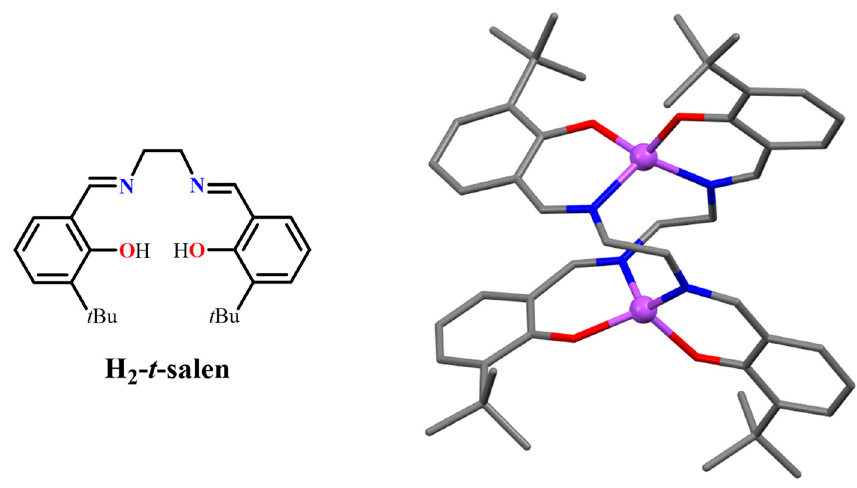
Figure 3. Molecular drawing of the H 2 - t -salen ligand ( left ) and crystal structure of the Zn 2 ( t -salen) 2 complex 2 ( right ). Adapted from Ref. [19].